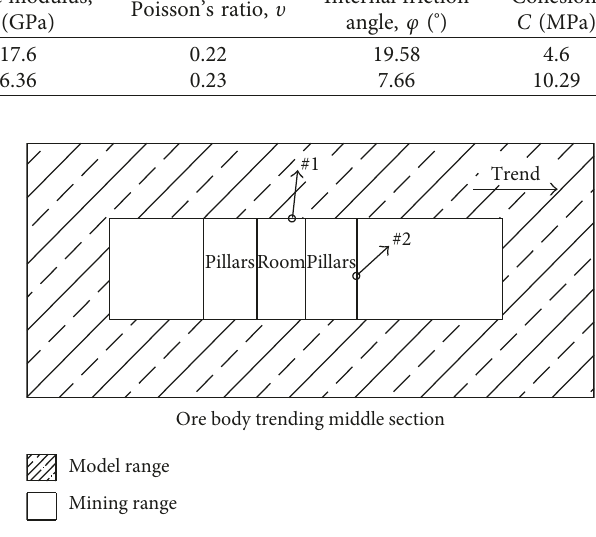
Figure 3: Model monitoring point layout